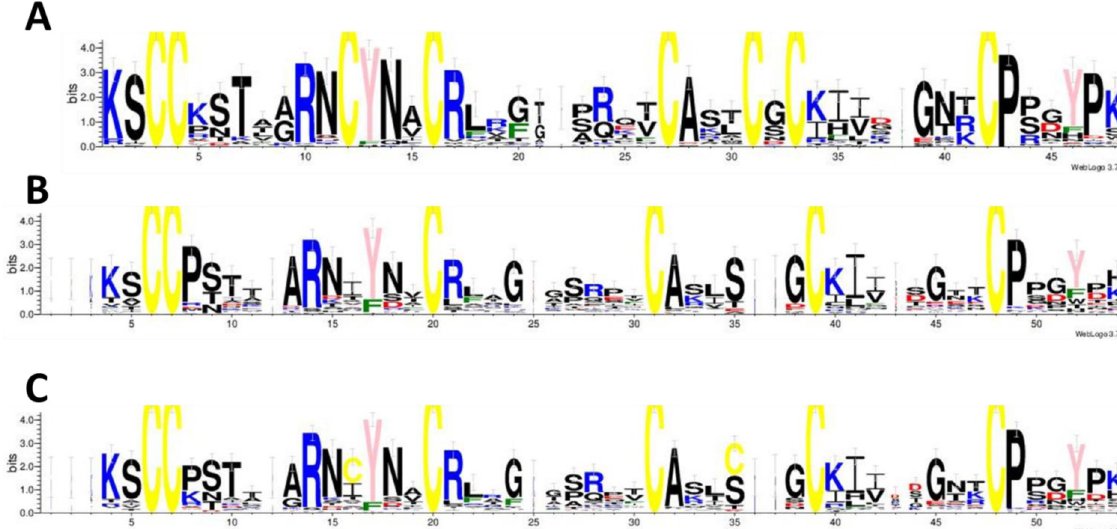
Fig 3. Sequence logos for thionins discovered by the 1KP project. A, class 1 thionins; B, class 2 thionins; C, class 1 and class 2 thionins. Cysteine yellow, basic amino acids blue, acidic amino acids red, tyrosine pink, phenylalanine green.